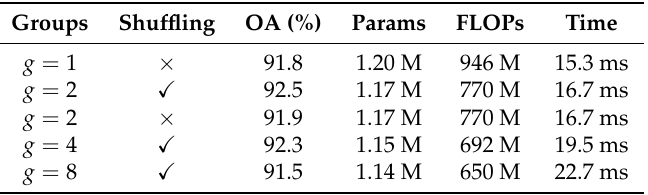
Table 2. Model complexity and accuracy for different groups.